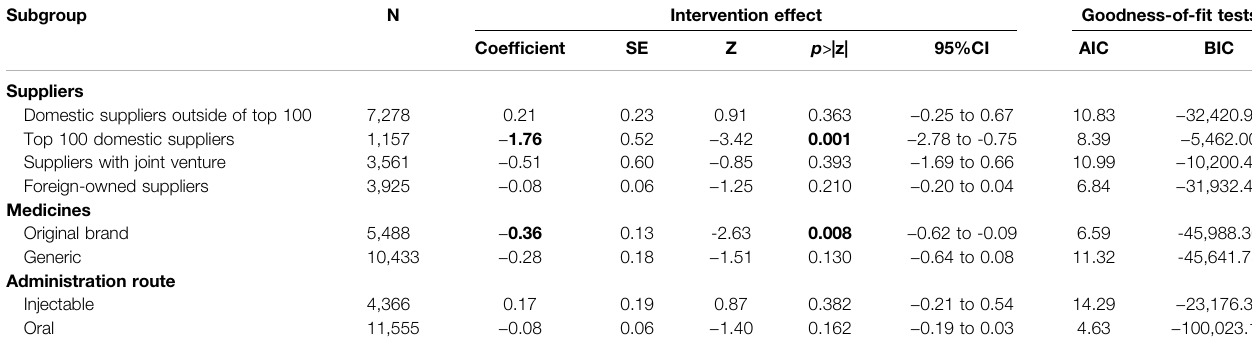
TABLE 5 | Subgroup difference-in-differences analyses (generalized linear regression) on unit price of procured cardiovascular medicines. Subgroup